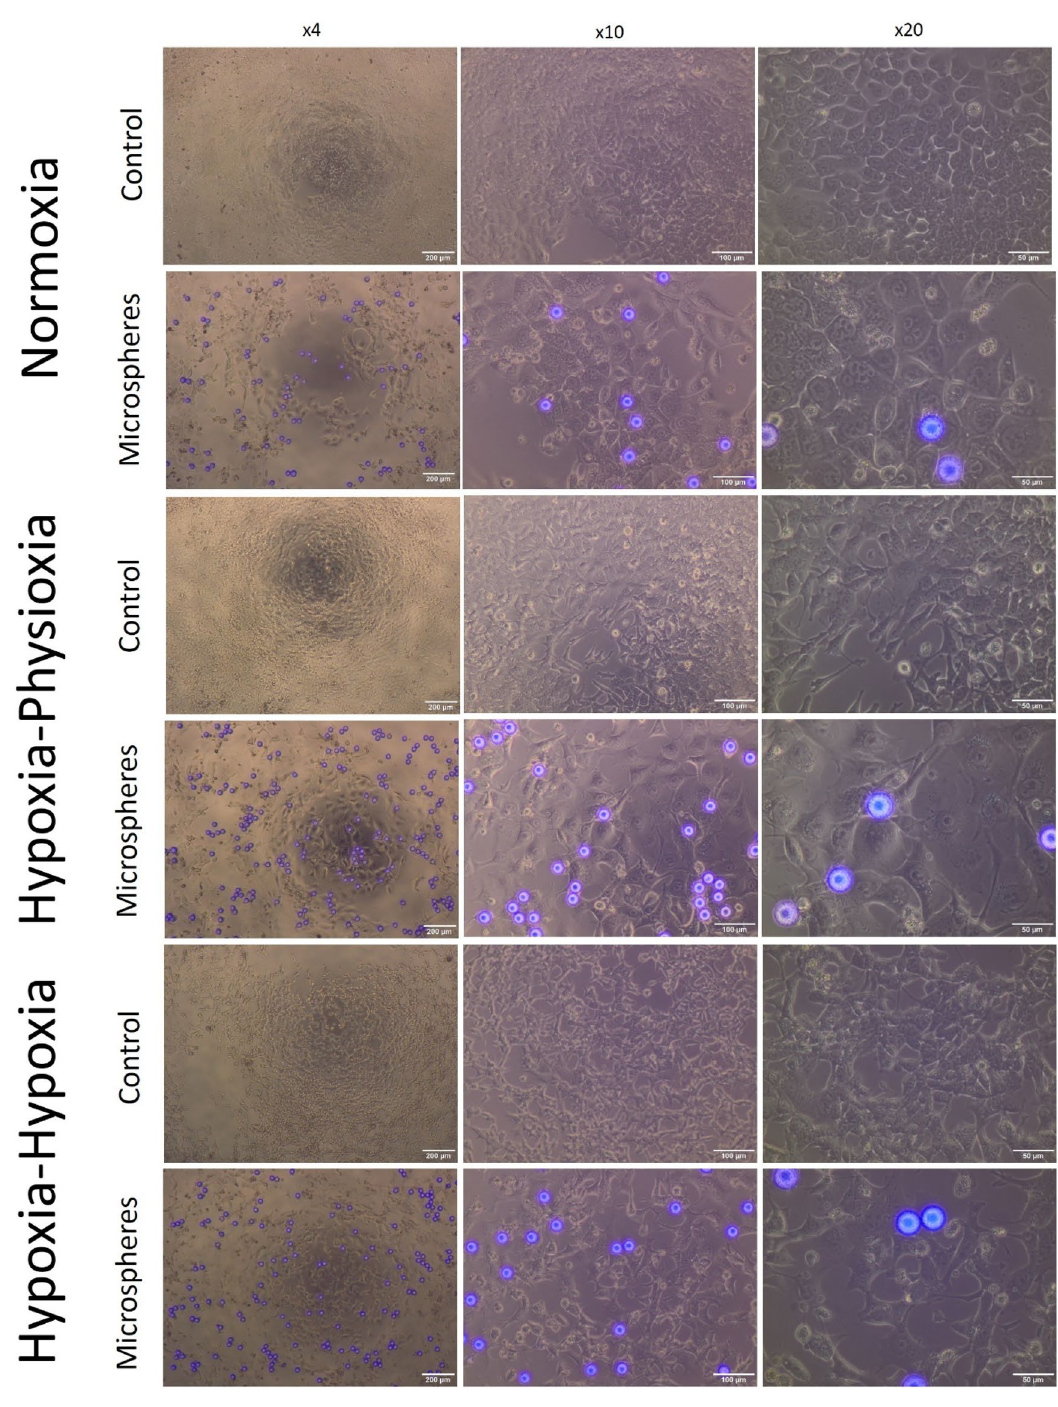
Figure 7. Microscopic observations of control cells treated with microspheres (after 96 h) under several magnifications (× 4, × 10, × 20) in various oxygenation conditions (compared to the corresponding control). Fluorescent spheres are 90 Absorbed dose and number of radiating microspheres.. Significant differences between the growth of HCT116 cancer cell lines in the control compared to plates with 90 Y-microspheres under various oxygen con- ditions were observed in our study. The effects were linked to the number of 90 Y microspheres and the absorbed dose. Non-homogenous 90 Y-microsphere spread within metastatic liver tumors lead to variable concentrations of 90 Y-particles in different tumor sections, which affected the amount of tumor absorbed dose 18,33 . American